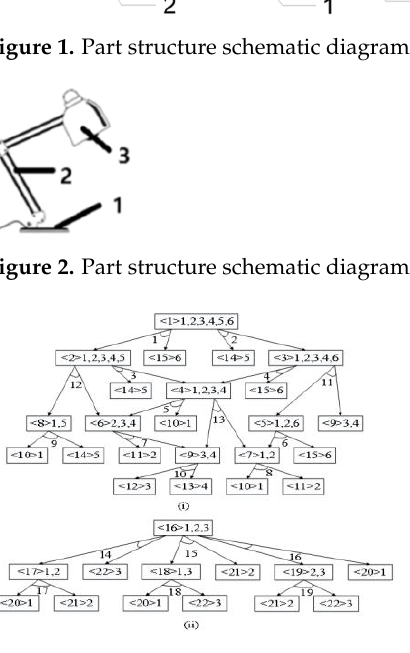
Figure 3. AND/OR graphs of ( i ) a ballpoint pen and ( ii ) a lamp.